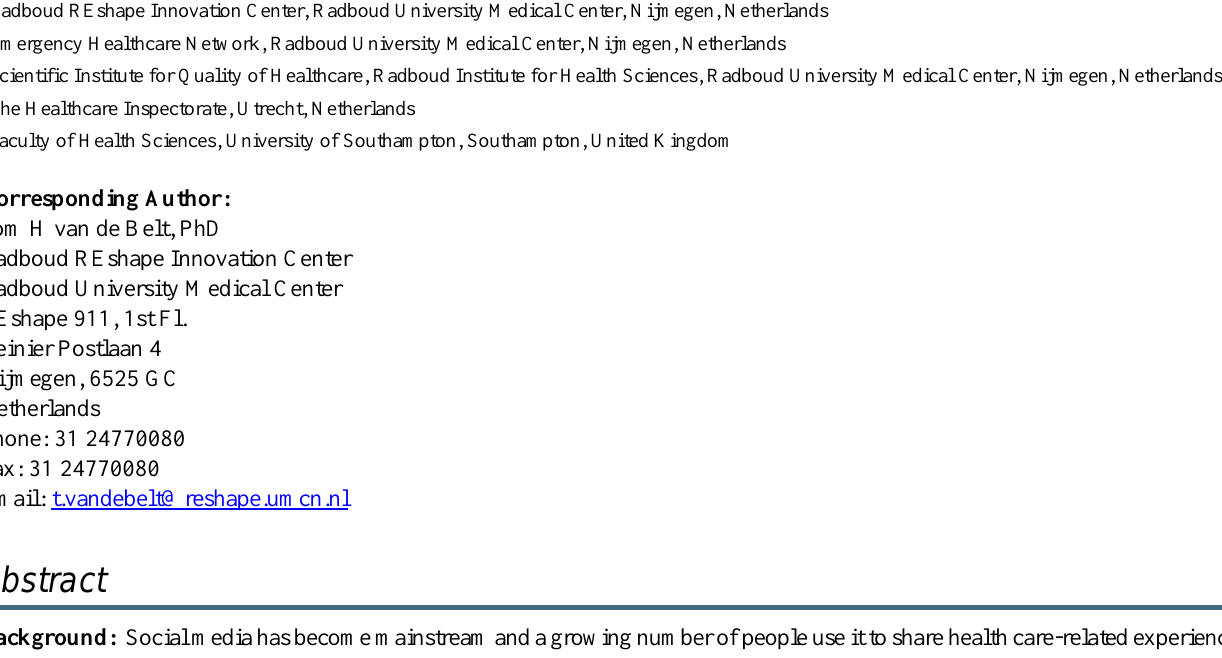
social media; rating sites; patient safety;